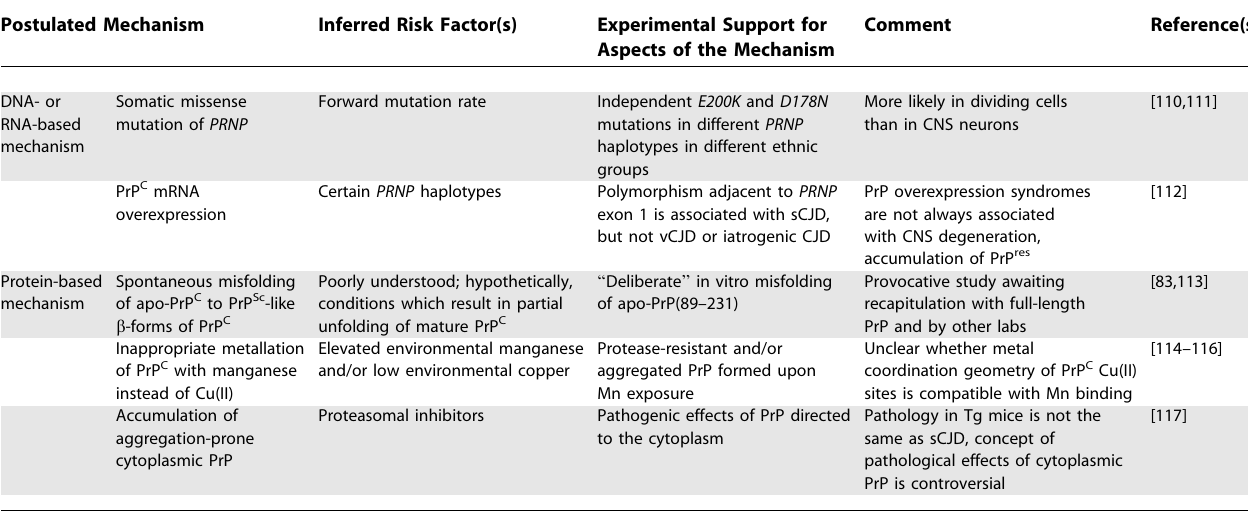
Table 3. Hypothetical Mechanisms for De Novo Creation of Prion Infectivity Postulated